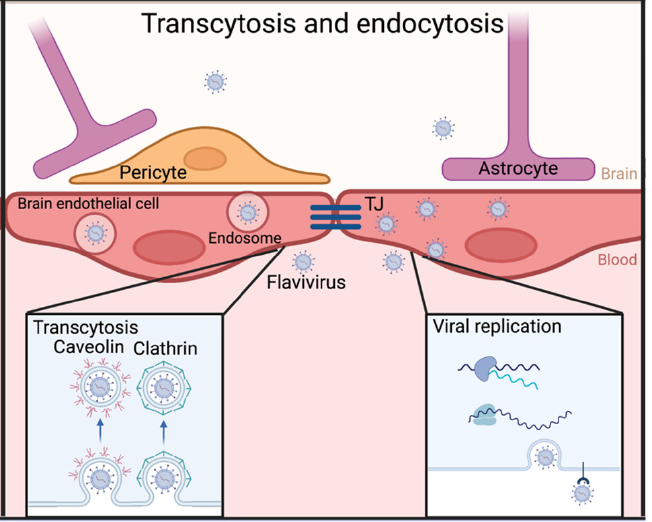
Figure 2. Flaviviruses bypassing an intact BBB via transcytosis and endocytosis. Made in Biorender. Transcytosis is the mechanism where molecules, or in this case viruses, are trans ‐ ported across an endothelial cell layer by intracellular vesicles. The virus is endocytosed